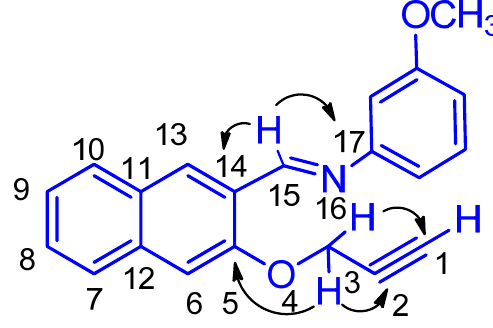
Figure 2. Selected HMBC of 5g .